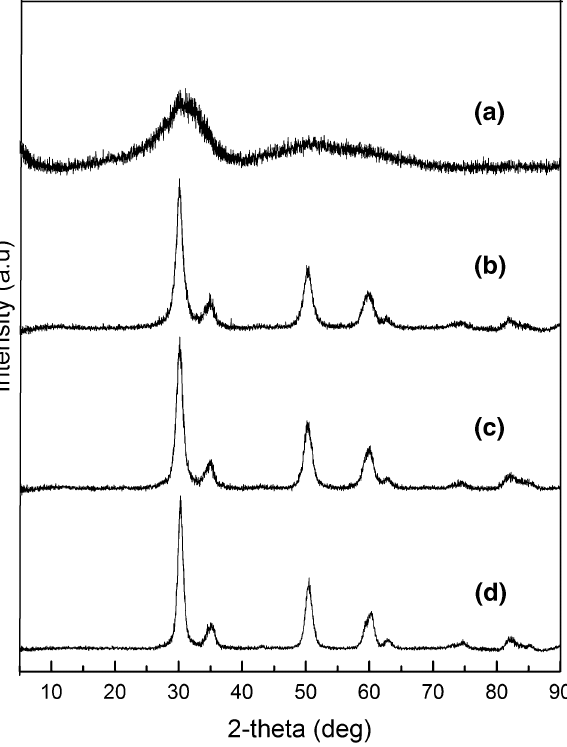
Fig. 1 Diffractogram of sulfated zirconia calcined at different temperatures: a 400 (cid:3) C, b 500 (cid:3) C, c 600 (cid:3) C, and d 700 (cid:3)